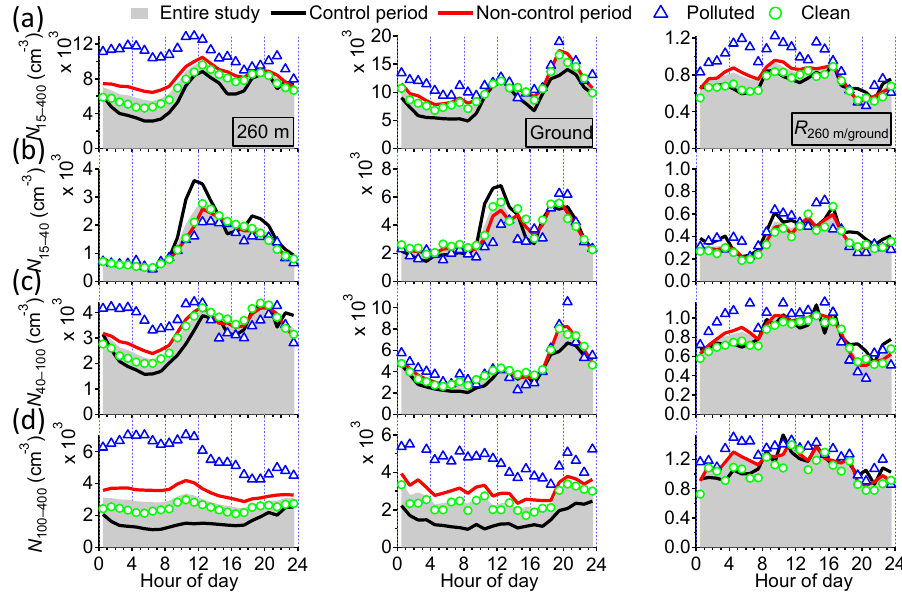
Figure 6. The diurnal cycles of particle number concentrations at 260m and ground level and the ratios of 260m to ground level for different size ranges, i.e., (a) 15–400nm ( N 15 − 400 ) , (b) small Aitken mode ( N 15 − 40 ) , (c) large Aitken mode ( N 40 − 100 ) , and (d) accumulation mode ( N 100 − 400 )